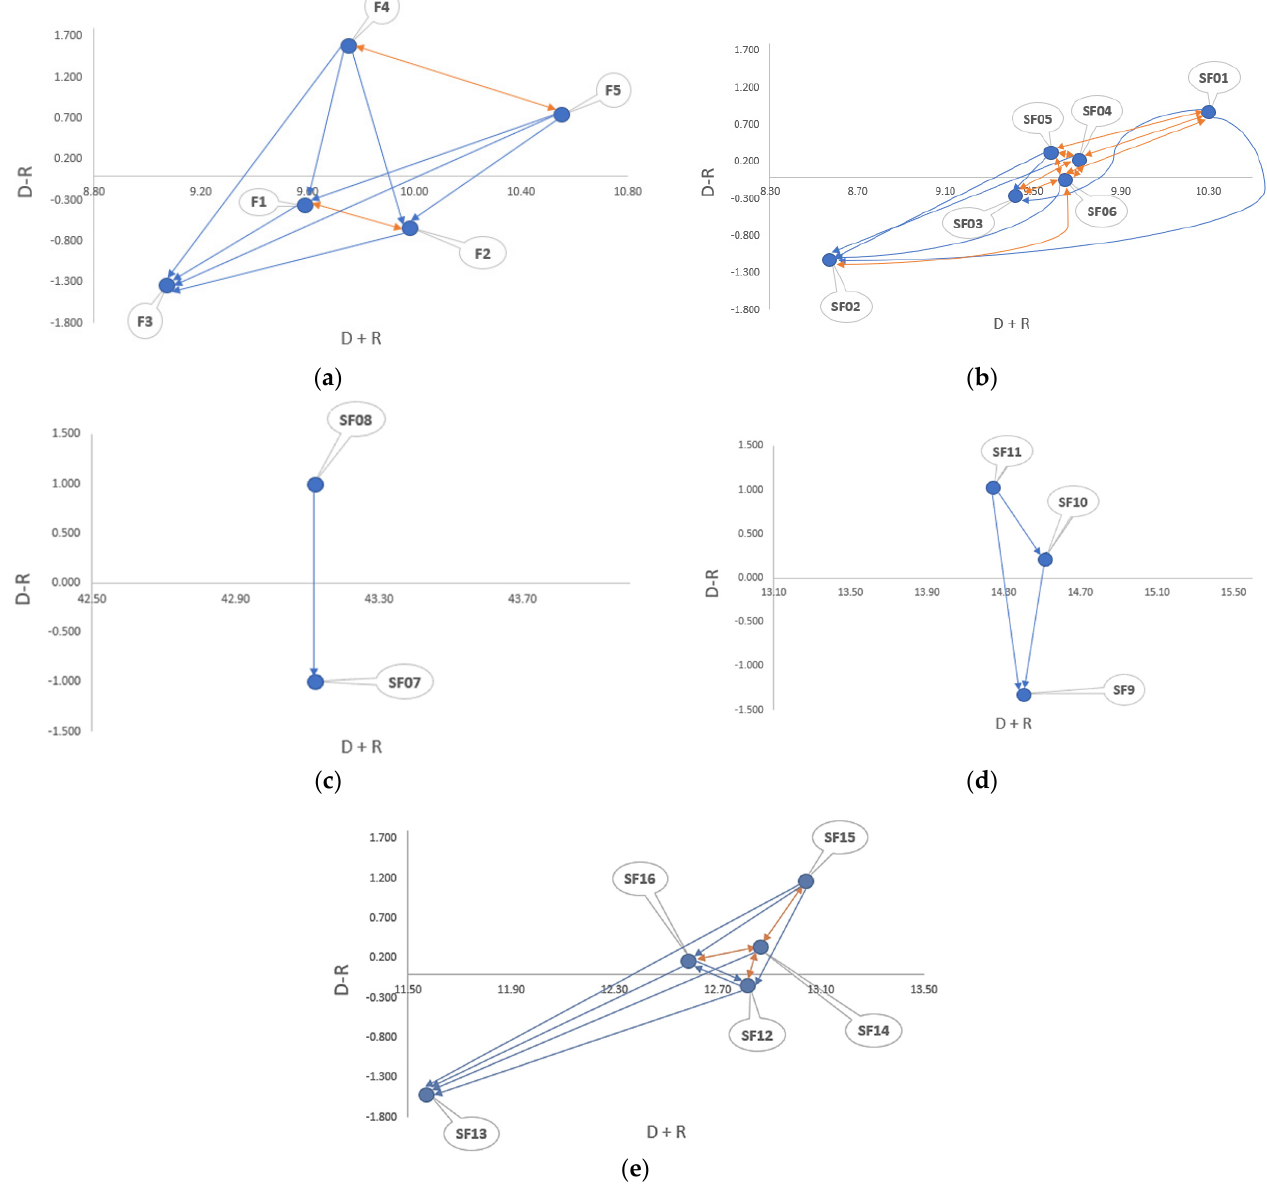
Figure 4. Impact-digraph map for ( a ) criteria, ( b ) classifier performance, ( c ) applicability, ( d ) adapt- ability, and ( e ) classifier architecture.